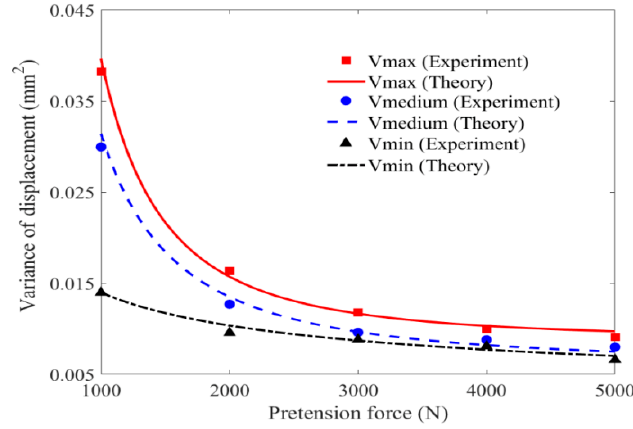
Figure 17. Variance value of displacement versus pretension force.